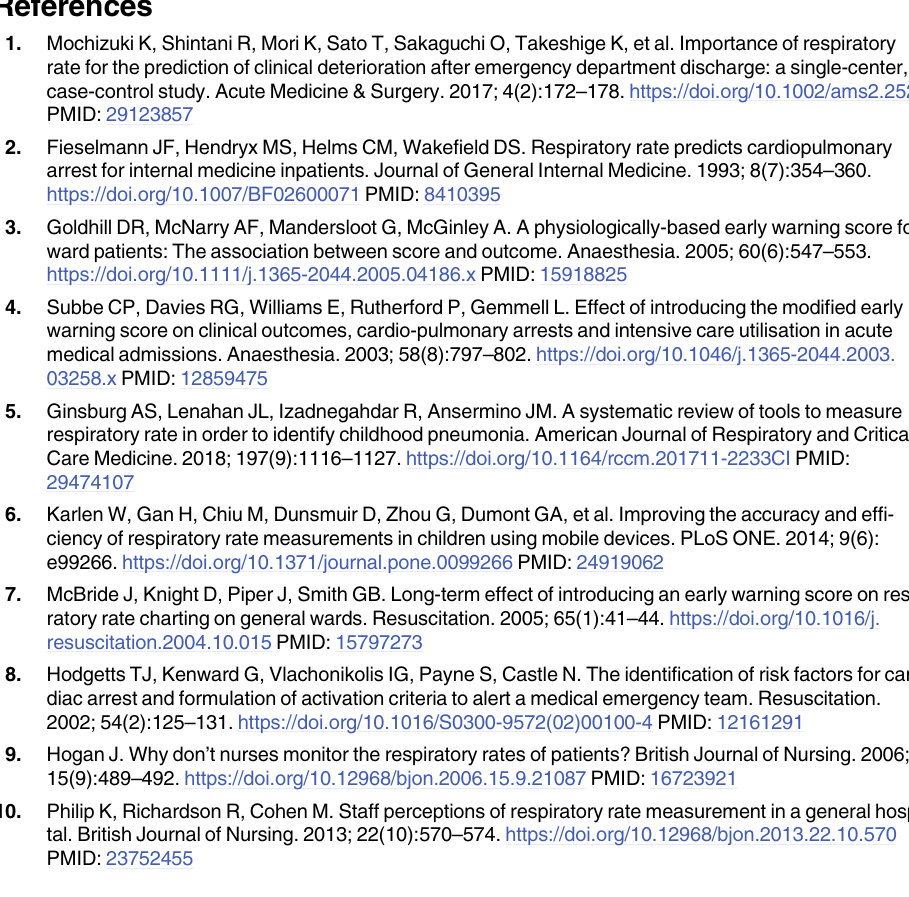
S1 Table. Respiratory rate distribution in 20-second segment dataset. S2 Table. Respiratory rate distribution in 30-second segment dataset. S3 Table. Respiratory rate distribution in 60-second segment